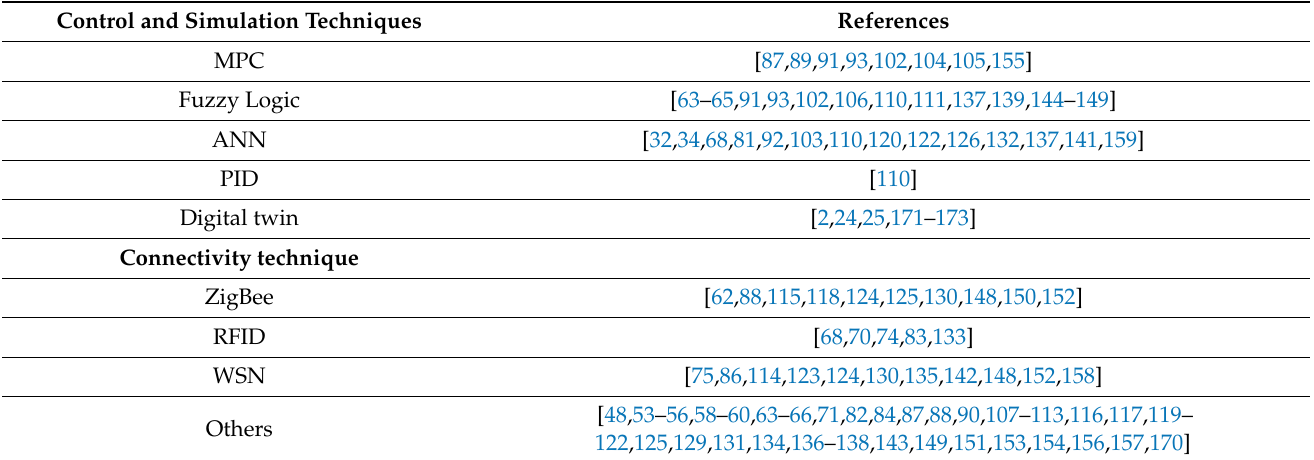
Table 3. Control and connectivity techniques used to optimize monitoring and control in the smart